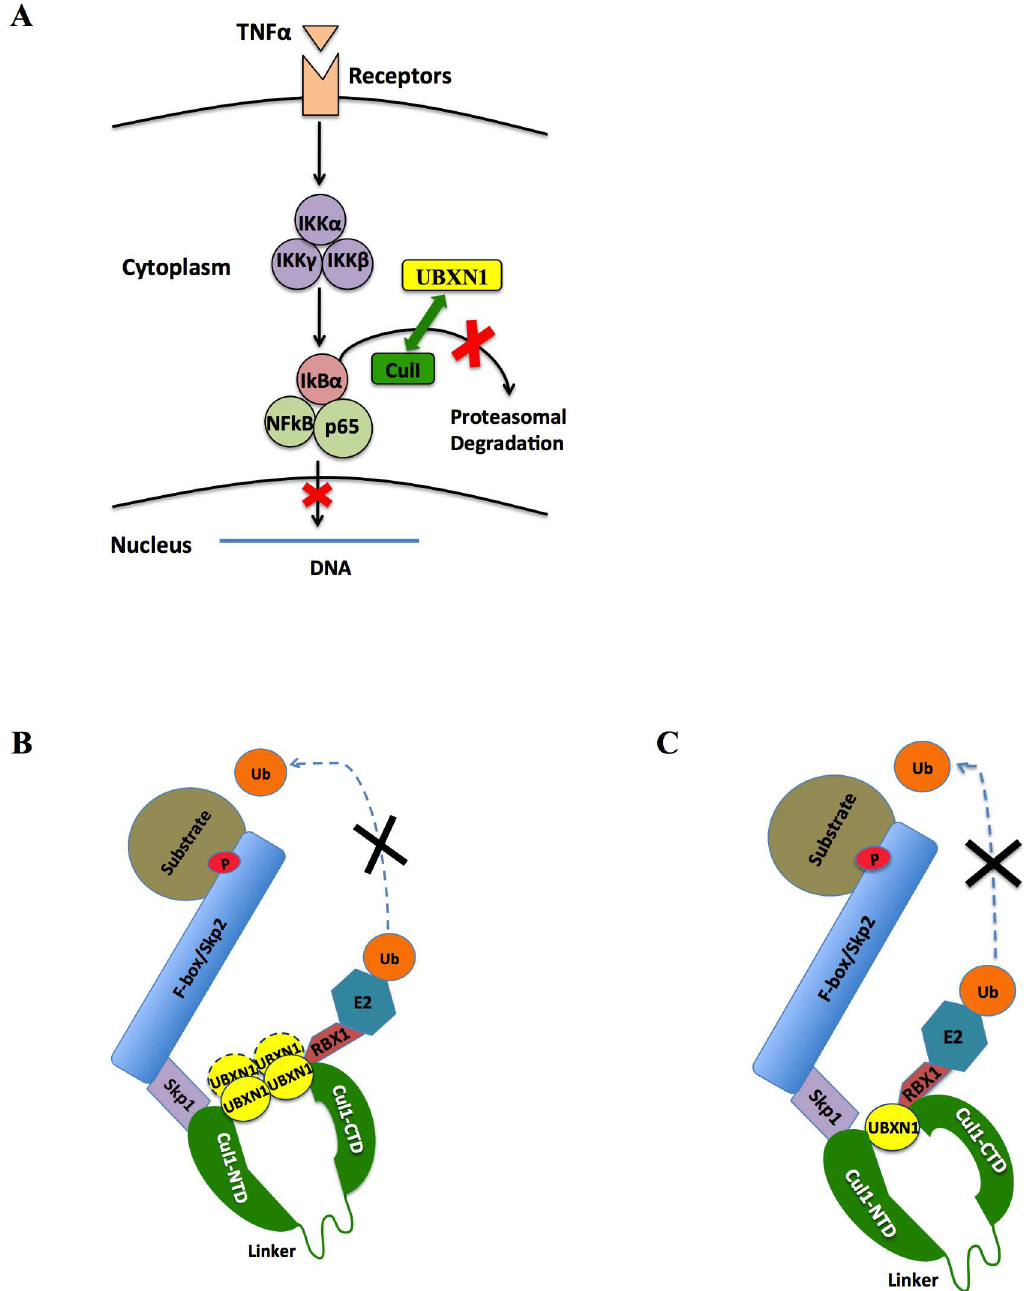
Fig 7. Schematic models of UBXN1 interaction with Cul1. (A) Cartoonrenderingof how UBXN1 may be interfering with Cul1 in the canonicalNF κ B signalingpathway; (B) and (C) additionalschematics of how UBXN1 may somehowbe interfering with Cul1 activity either by steric hindrance (B) or allosteric effect (C) . UBXN1 is known to multimerizeand interacts with both N and C termini of Cul1; stoichiometry betweenUBXN1 and Cul1 is not known(dashedovals). In both models Skp1 and Rbx1 interact with the N and C termini of Cul1, respectively,and UBXN1 interacts with Rbx1 but not Skp1. These models do not excludethe possibilitythat another factor or protein (e.g., multimerized ubiquitin) mediatesthe interactionbetweenUBXN1 and